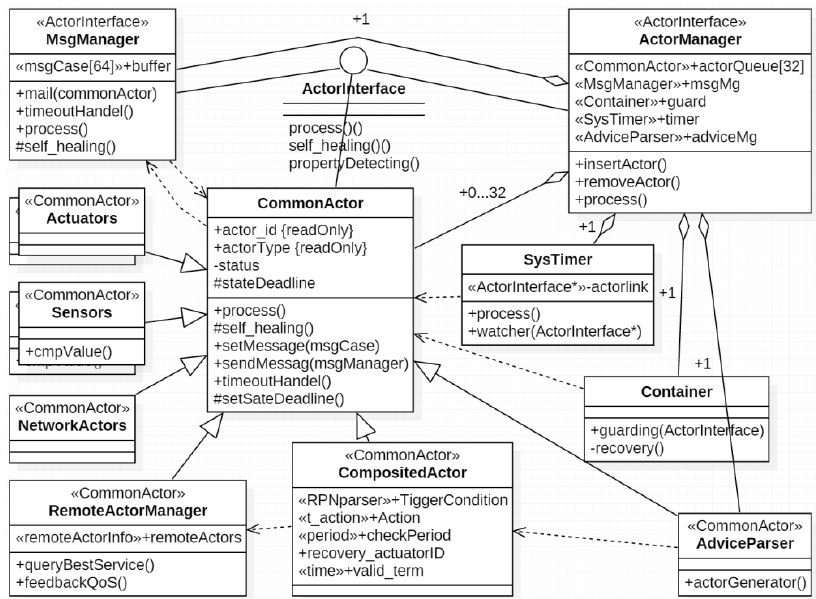
Figure 11. Self-similar actor interface.